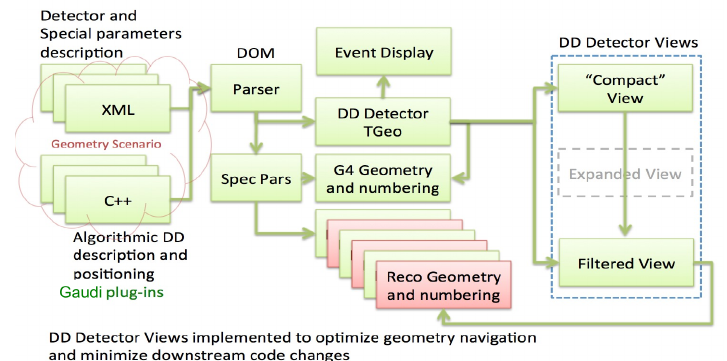
Figure 2. Diagram showing the CMS detector description using DD4hep. DD4hep uses a DOM (Doc- ument Object Model) parser that parses the XML document all together in a state-dependent manner. In this diagram, "G4" refers to the Geant4 simulation toolkit, "Reco" refers to particle reconstruction, and "TGeo" refers to the ROOT geometry